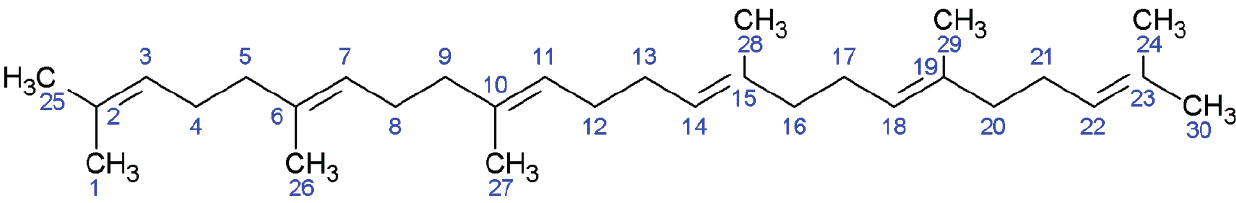
Figure 1. Structure of SQ. Numbering of carbons used throughout the text of this